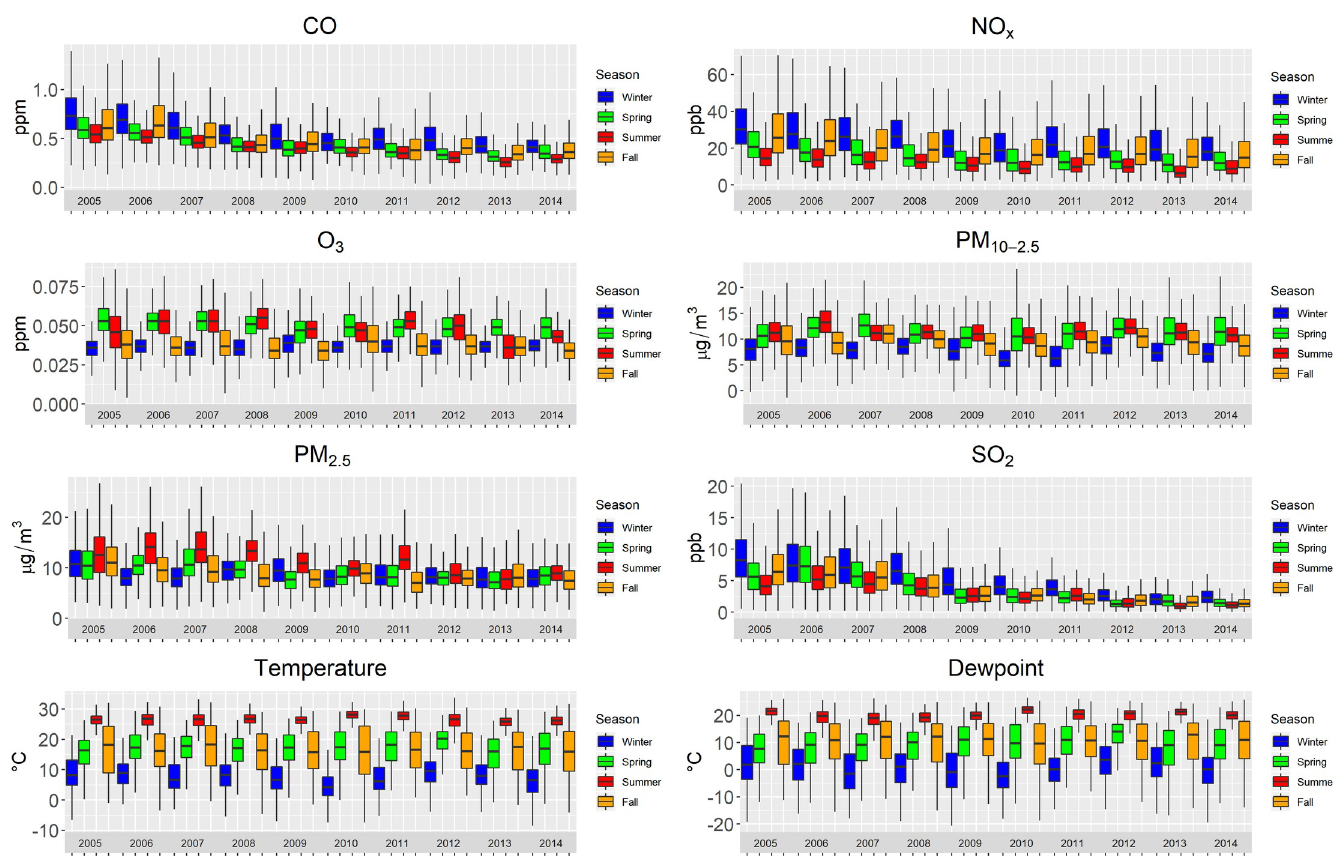
Fig 4. Estimated air pollution levels over time by pollutant and asthma season (winter: January 1 –February 28; spring: March 1 –May 31; summer: June 1 – August 19; fall: August 20 –December 31) in South Carolina from 2005 to 2014.